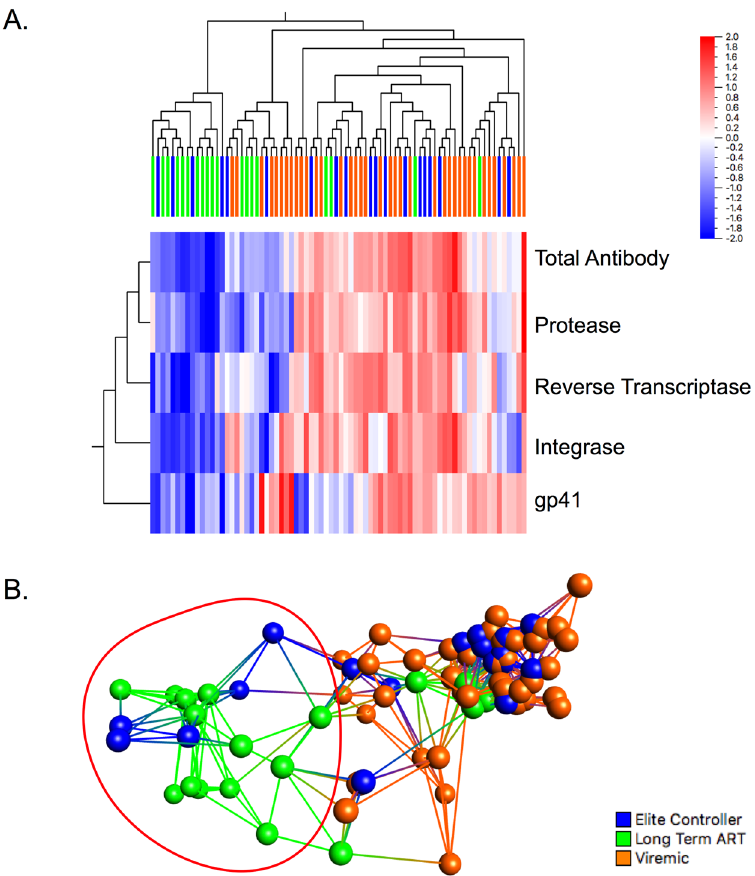
Figure 3. ( A ) The antibody response profiles using hierarchical clustering and ( B ) principal component analysis (PCA) analysis based on the four HIV-1 antigens and the total antibody response. The analysis was performed at a stringent false discover rate (FDR) adjusted p (q) < 0.001 using